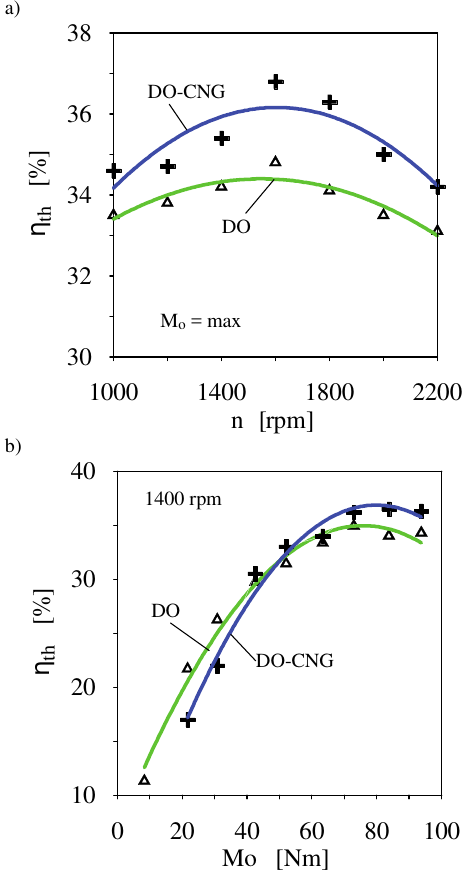
Fig. 5. Comparison of overall efficiency of SB3.1 engine run on diesel oil (DO) and in dual fuel system run on diesel oil and CNG gas (DO-CNG): initial dose q = 14.6 mm 3